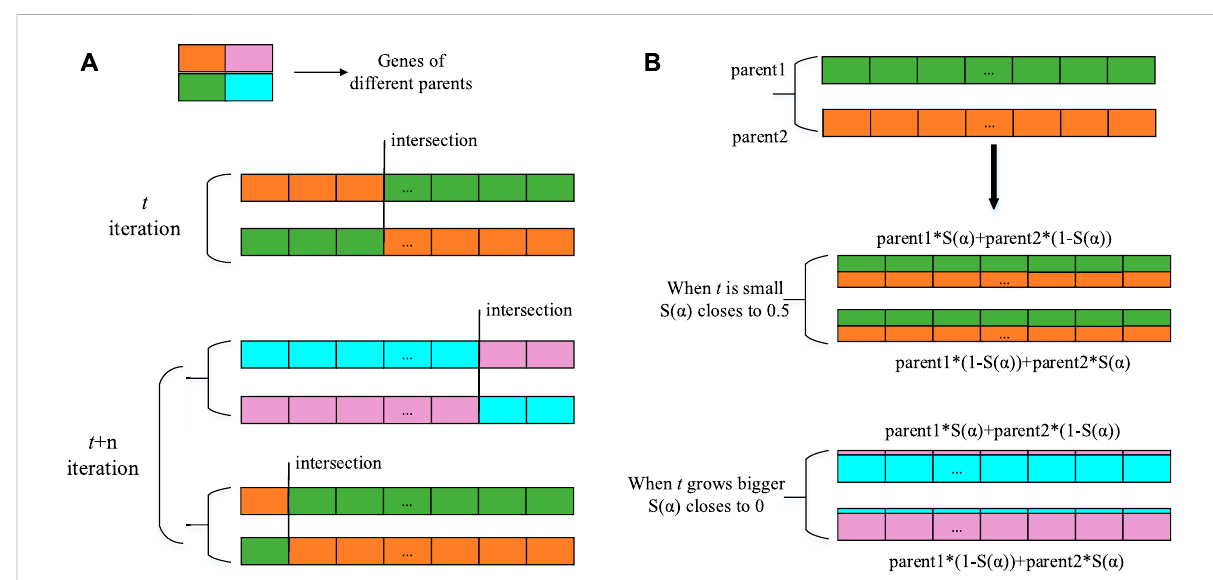
FIGURE 4 Comparison between the Gaussian and Cauchy distribution